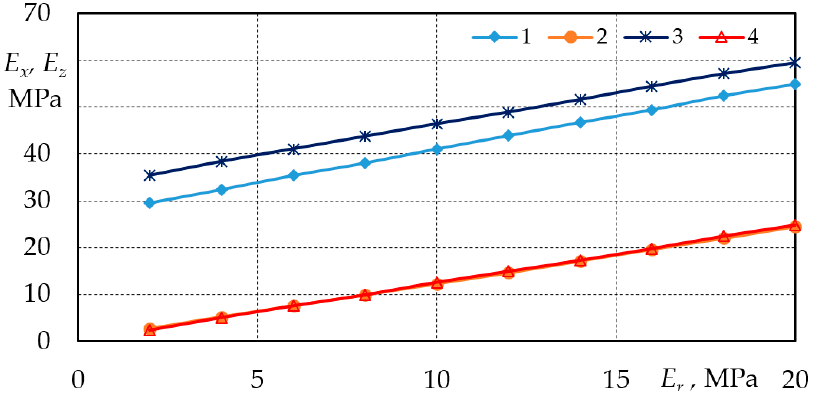
Figure 12. Tire band elastic modulus in X and Z directions: 1—model a (8 layers) in X direction, 2—model a in Z direction, 3—model b (7 layers) in X direction, and 4—model b in Z direction.